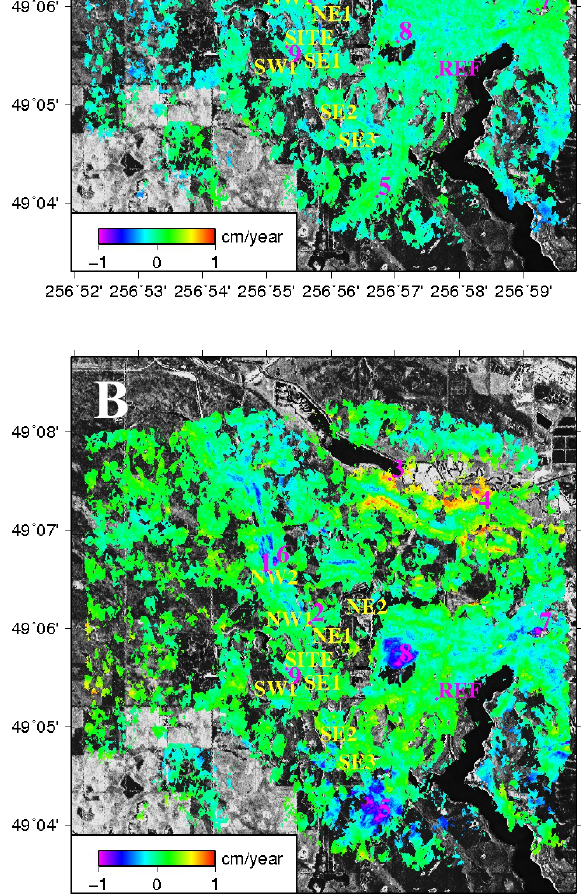
Figure 6. (A) Horizontal MSBAS linear deformation rate map for June 2012 - July 2014, (B) Vertical MSBAS linear deformation rate map for June 2012 - July 2014. MSBAS reference point is marked by magenta dot and labeled REF, location of Aquistore injection well site and labeled SITE as well as corner reflectors are marked by yellow. DInSAR time series sites are numbered from 1 to 9 by magenta. The background is RADARSAT-2 Spotlight